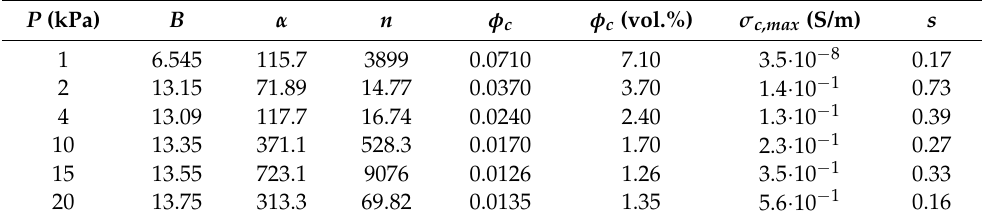
Table 3. The values of adjustable parameters, B , α , n of Equation (3), φ c , calculated percolation threshold concentration from Equation (4) in volume fraction and vol.% and σ c,max is the calculated maximum of conductivity. P is the pressure and s is the standard deviation of